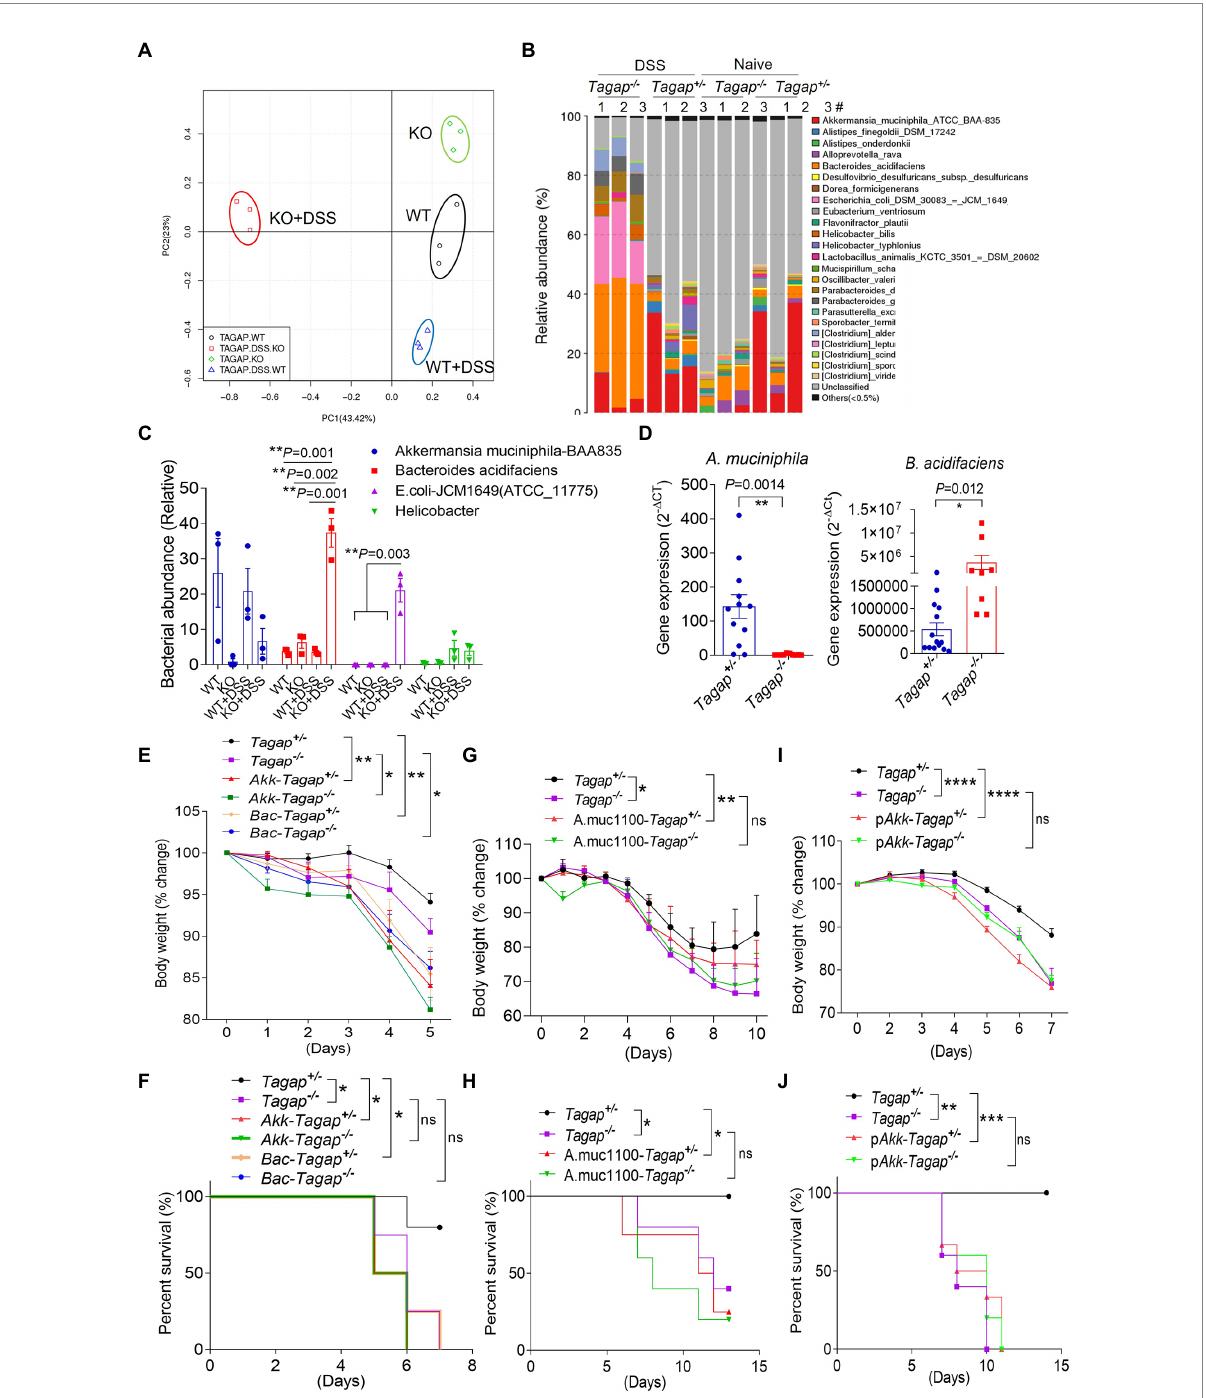
FIGURE 4 TAGAP-deficient mice had altered microbiota in the gut. (A,B) Cluster analysis or diversity analysis of overall gut microbiota in the littermate control mice or TAGAP-deficient mice, n = 3. (C) Relative abundance of different bacterial strain in the feces of littermate control mice or TAGAP- deficient mice identified by 16S sequencing was shown, n = 3. (D) Feces from littermate control mice or TAGAP-deficient mice were collected and analyzed by real time PCR for the indicated bacterial strains, n = 12. (E,F) Littermate control mice or TAGAP-deficient mice were oral gavaged Akkermansia muciniphila or Bacteroides acidifaciens daily for 4 weeks (1 × 10 8 /mouse/day), followed by 2.5% of DSS treatment for 5 days, and then changed to normal water. The weight loss (E) and survival data (F) were from separate experiments. (G,H) Littermate control mice or TAGAP- deficient mice were oral gavaged recombinant Amuc_1100 protein daily for 4 weeks (10 μ g/mouse/day), followed by 2.5% of DSS treatment for 5 days. The weight loss (G) and survival data (H) were from separate experiments. (I,J) Littermate control mice or TAGAP-deficient mice were oral gavaged pasteurized A. muciniphila daily for 4 weeks (1 × 10 8 /mouse/day), followed by 2.5% of DSS treatment for 5 days. The weight loss (I) and survival data (J) were from separate experiments, n = 5 for panels (E–J) . * p < 0.05, ** p < 0.01, *** p < 0.001, **** p < 0.0001 based on 2-way ANOVA (E,G,I) , Log-rank (Mantel-Cox) Test for panels (F,H,J) and unpaired T test (D) . Data are representative of two independent